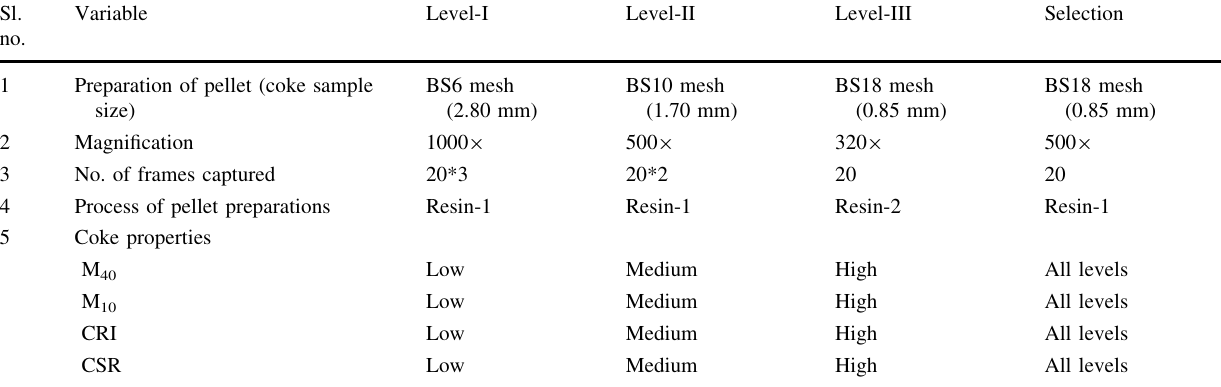
Table 1 The experimental design for image analysis Sl. no.